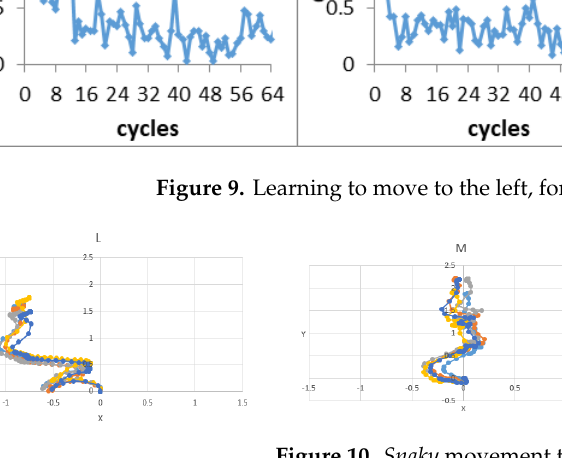
Figure 10. Snaky movement trajectories.